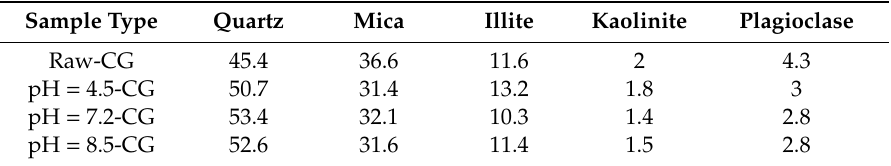
Figure 2. X-ray diffraction of CG samples. Note: Cu—K α radiation wavelength radiation is 0.154 nm. According to XRD testing, the calculation results of substances in the coal gangue samples by Jade Software are shown in Table 4. Table 4. Content of each substance in the coal gangue samples by XRD/%